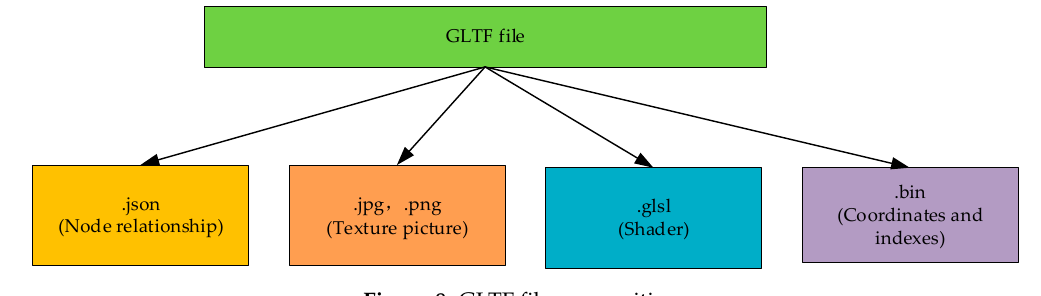
Figure 8. GLTF file composition.